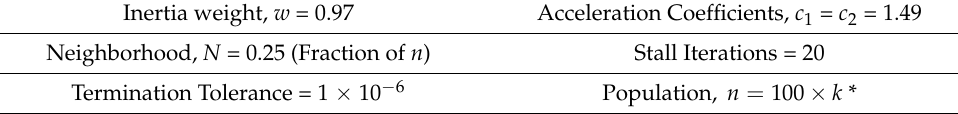
Table 1. PSO Parameters. Inertia weight, w =